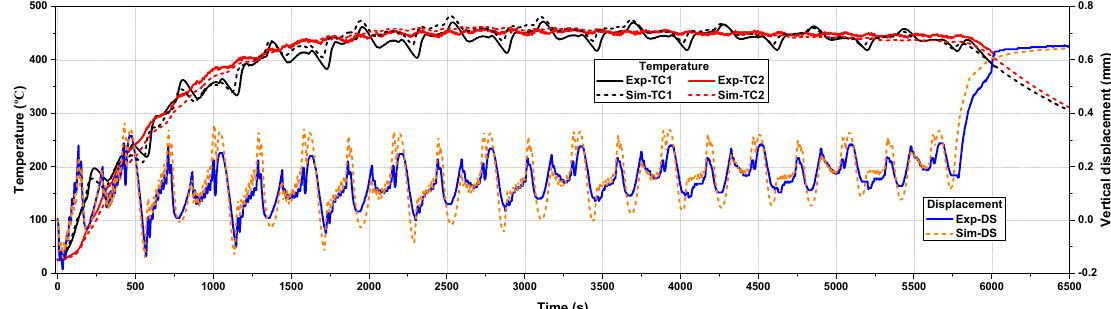
Figure 3. Comparison between simulated and measured thermo ‐ mechanical results of the block.